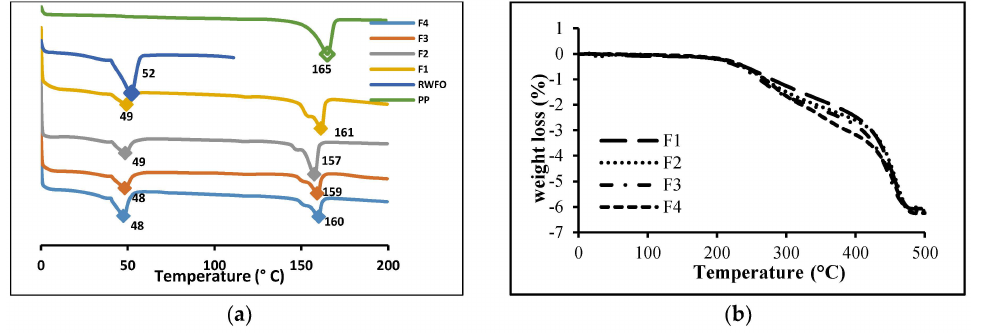
Figure 5. ( a ) DSC scans of the PP, RWFO and feedstock formulation; ( b ) TGA profile of different feedstock